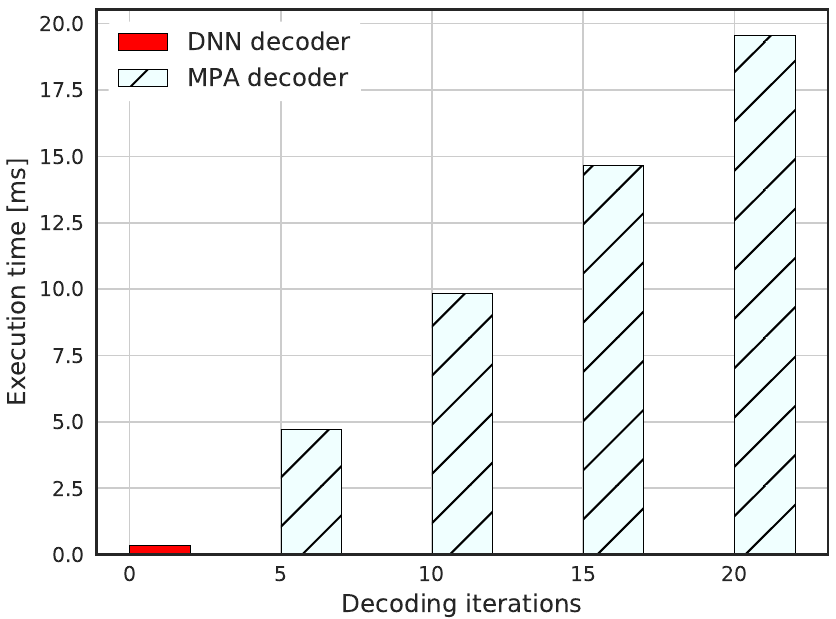
Figure 15. Complexity comparison for DNN-based SCMA and conventional MPA